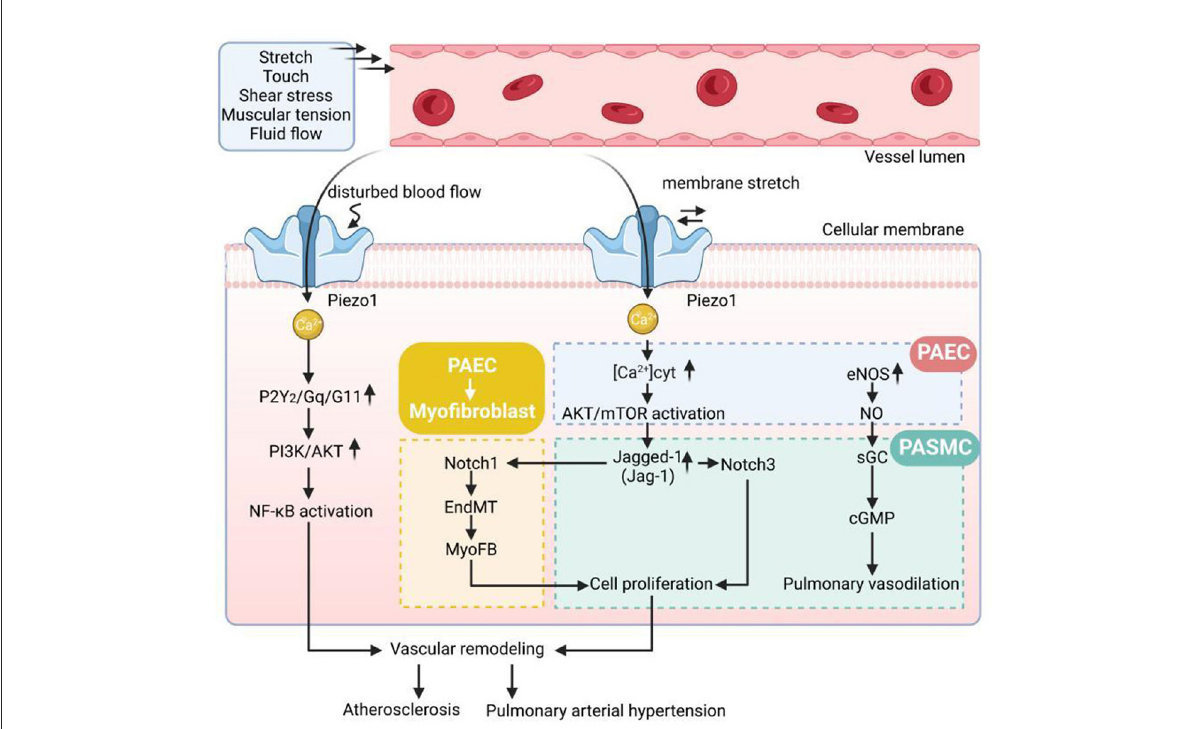
FIGURE1 The pathological mechanisms of vascular remodeling disease. Gq/G11, Gprotein alpha-subunits Galphaq/Galpha11; AKT, protein kinase B; PI3K, phosphatidylinositol 3 kinase; NF- κ B, nuclear factor kappa B; EndMT, endothelial-to-mesenchymal transition; [Ca 2 + ] cyt , cytoplasmic free Ca 2 + concentration; eNOS, endothelial nitric oxide synthase; NO, endothelial nitric oxide; sGC, soluble guanylate cyclase; cGMP, cyclic guanosine